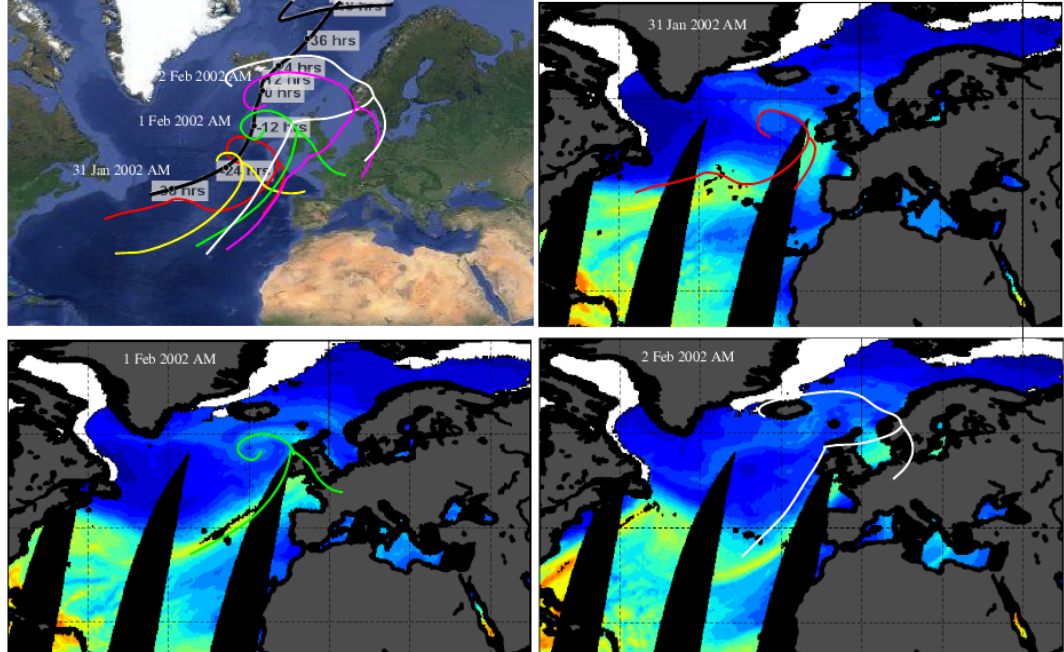
Figure 1. (a) Schematic showing positions of surface fronts at successive 12-hourly intervals, starting at 06:00UTC on 31 January 2002, and Special Sensor Microwave Imager (SSM/I F13) integrated water vapor on (b) 31 January 2002 overlaid with 06:00UTC on 31 January 2002 frontal positions, (c) on 1 February 2002 overlaid with 06:00UTC on 1 February 2002 frontal positions and (d) on 2 February 2002 overlaid with 06:00UTC on 2 February 2002 frontal positions (Fig. 8 in Dacre et al., 2015; used with permission © American Meteorological